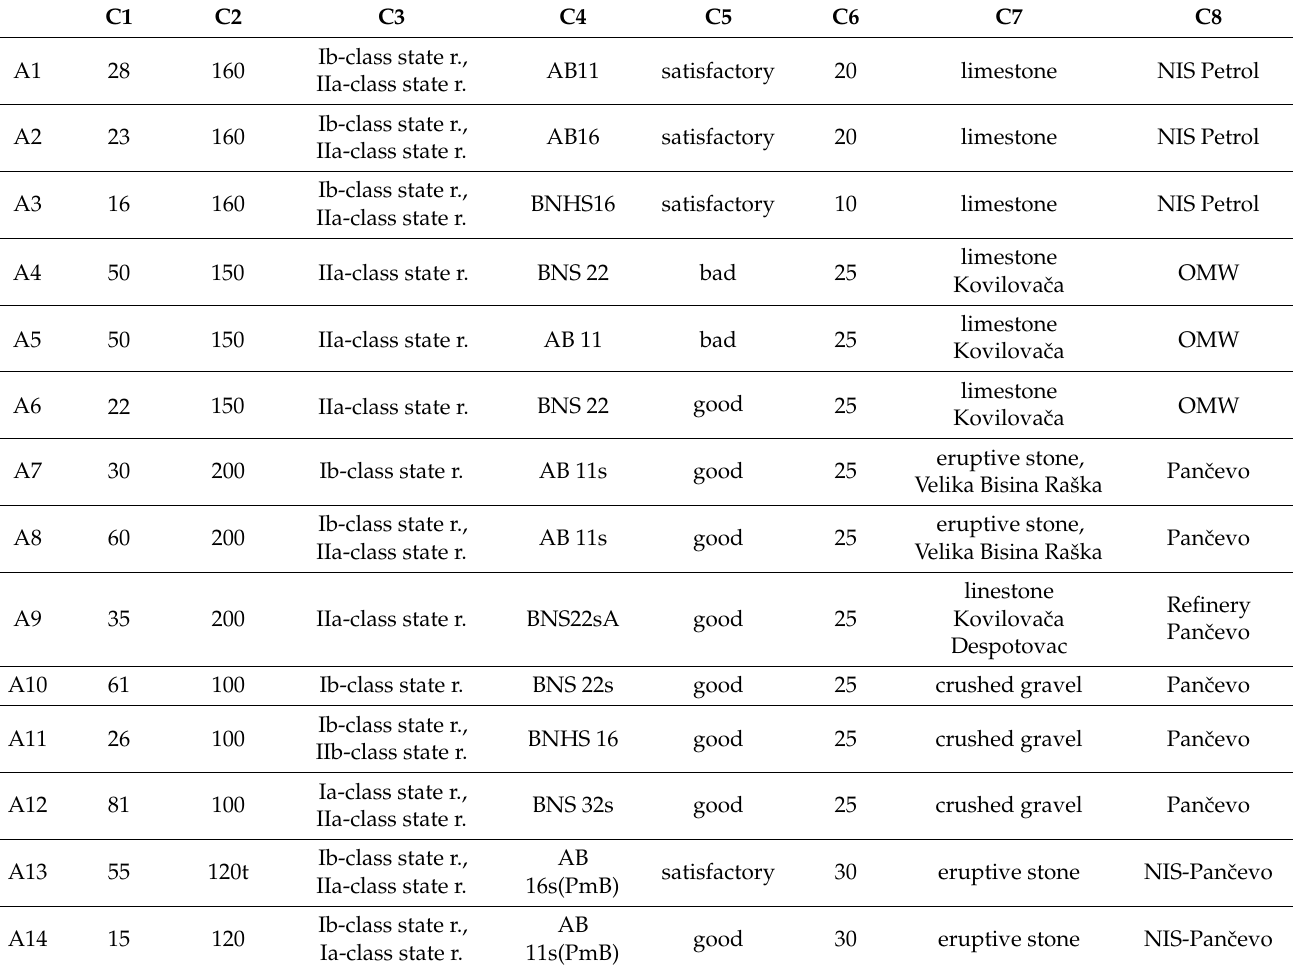
Table 3. Initial matrix as an input parameter for a group decision-making